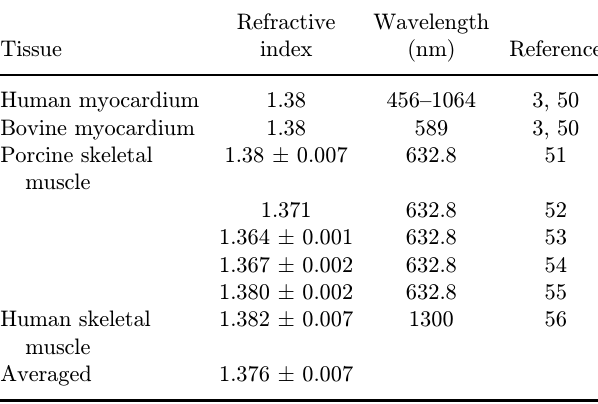
Table 1. Refractive indices of muscle